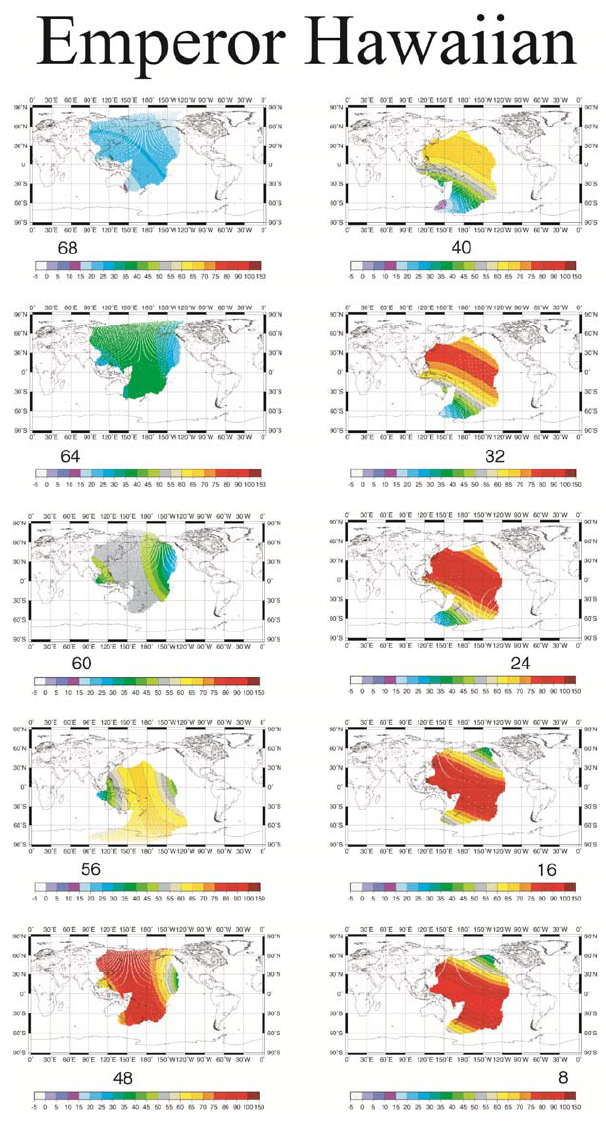
Figure 9. Stage pole velocities for Pacific Plate at labeled time on Emperor and Hawaiian seamount chains. From Bowin and Kuiper (2005).